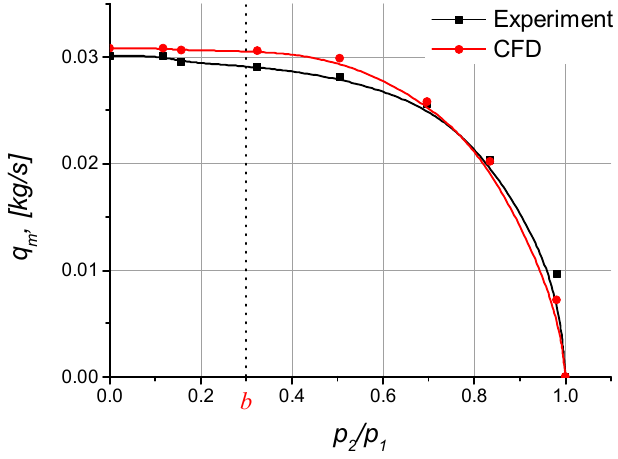
Figure 14. Mass flow rate vs. the pressure ratio.